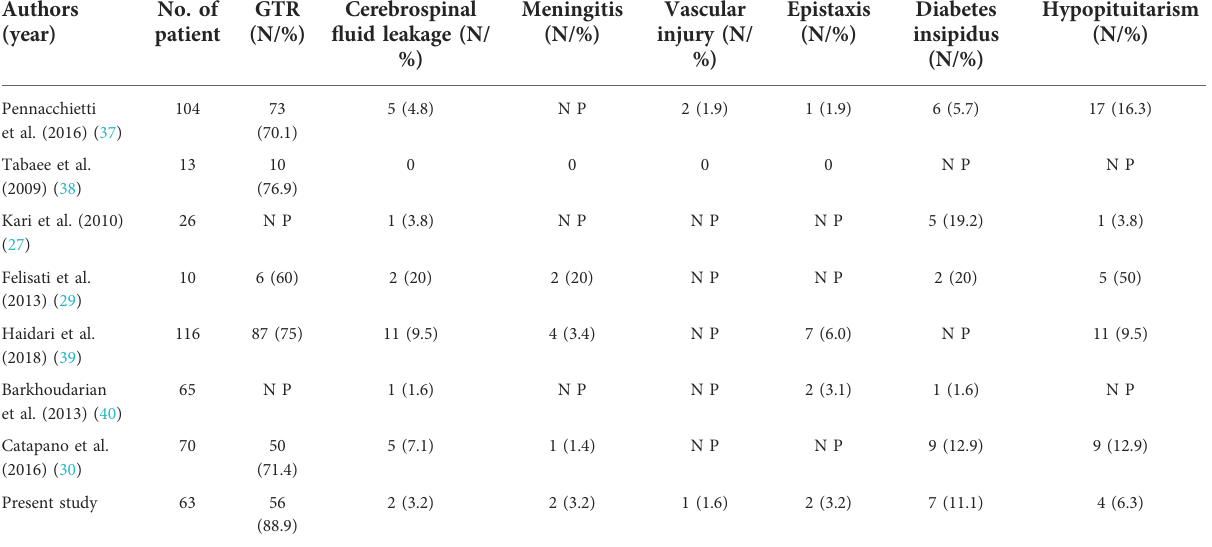
TABLE 4 Literature review of complications of 3D